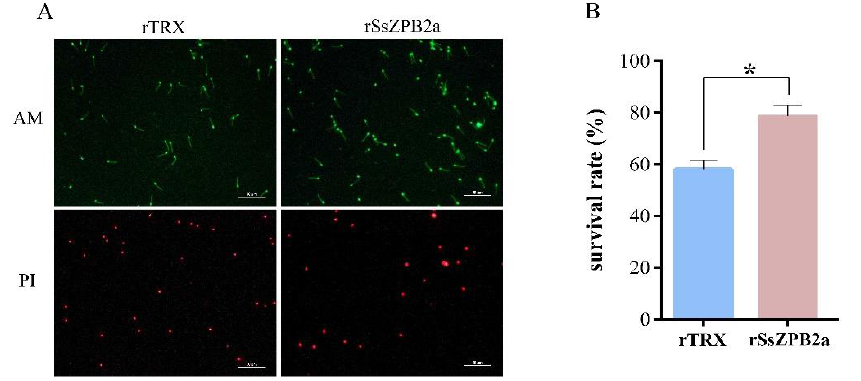
Figure 6. rSsZPB2a significantly enhances the survival rate of sperm cultivated in vitro. ( A ) The AM/PI staining of sperm incubated with rSsZPB2a or rTRX. ( B ) Statistics on sperm survival rate according to the AM/PI staining results. AM, calcein-AM; PI, Propidium iodide. * p <